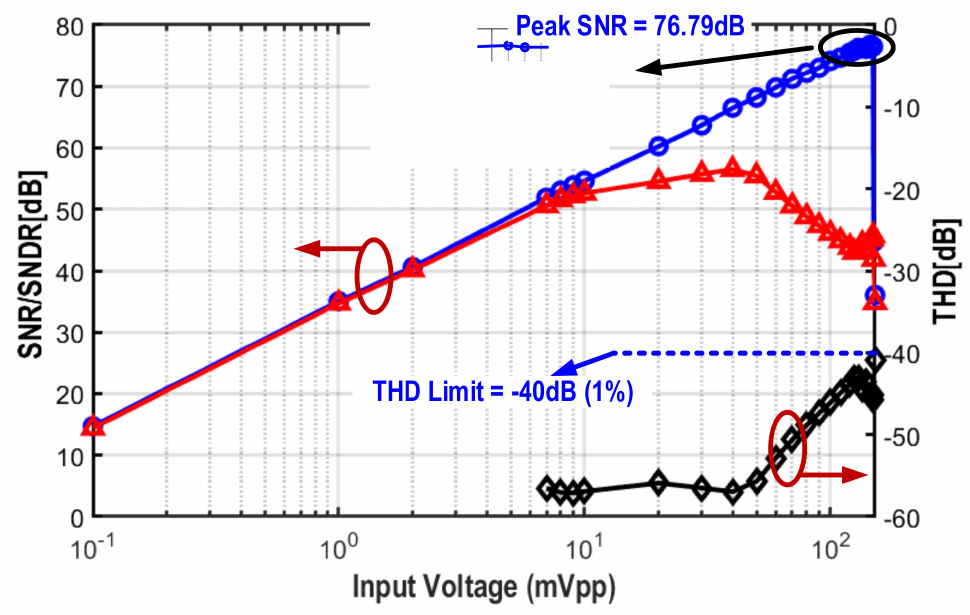
Figure 6. Measured DR over different input amplitudes and 0 mV DC offset (single